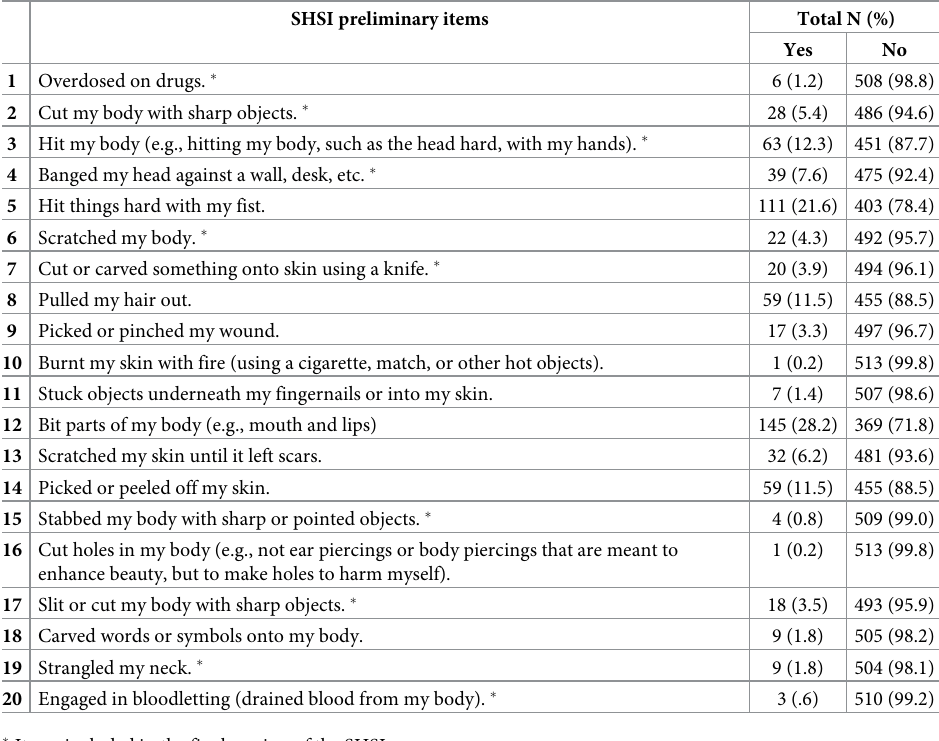
Table 1. Frequencies of the total sample (N = 514) endorsing the preliminary SHSI. SHSI preliminary items